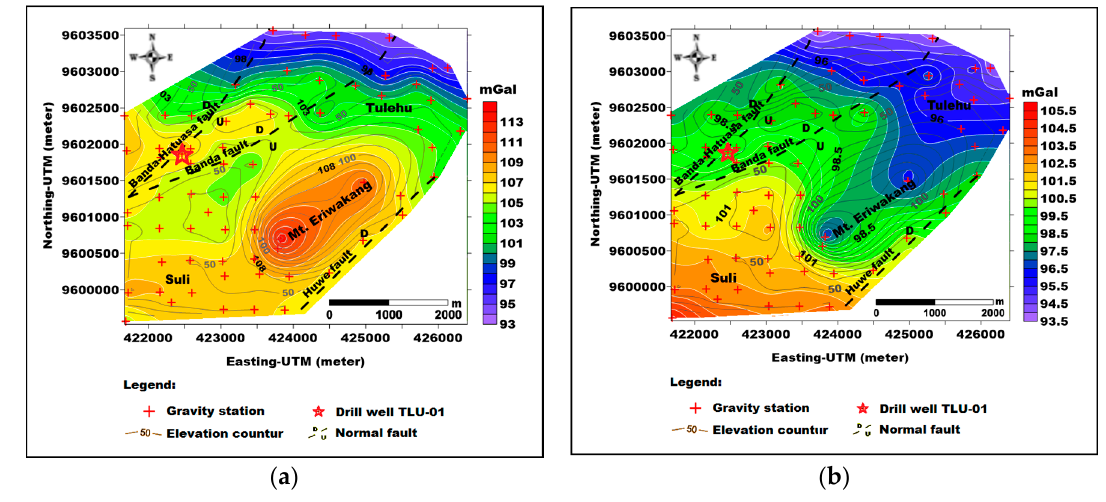
Figure 9. The gravity anomalies map of Suli and Tulehu geothermal areas ( a ) a free air anomaly; ( b ) a complete Bouguer anomaly.